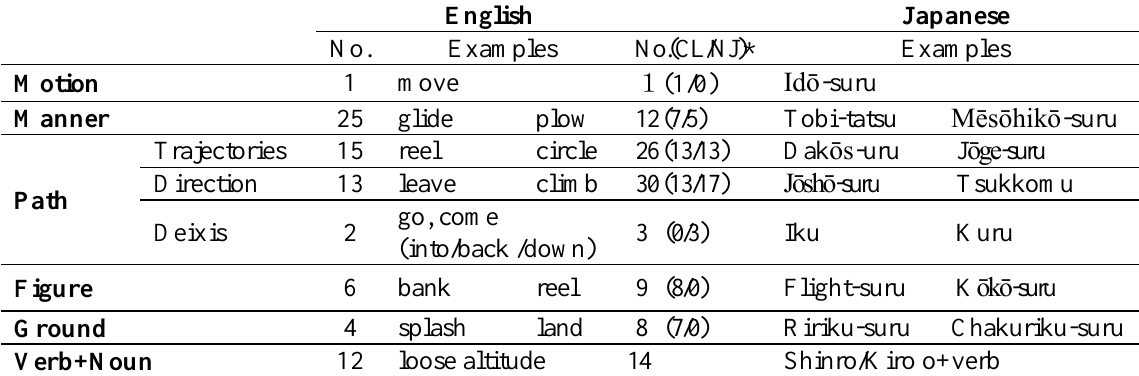
Figure 6 bank reel 9 (8/0) Ground splash